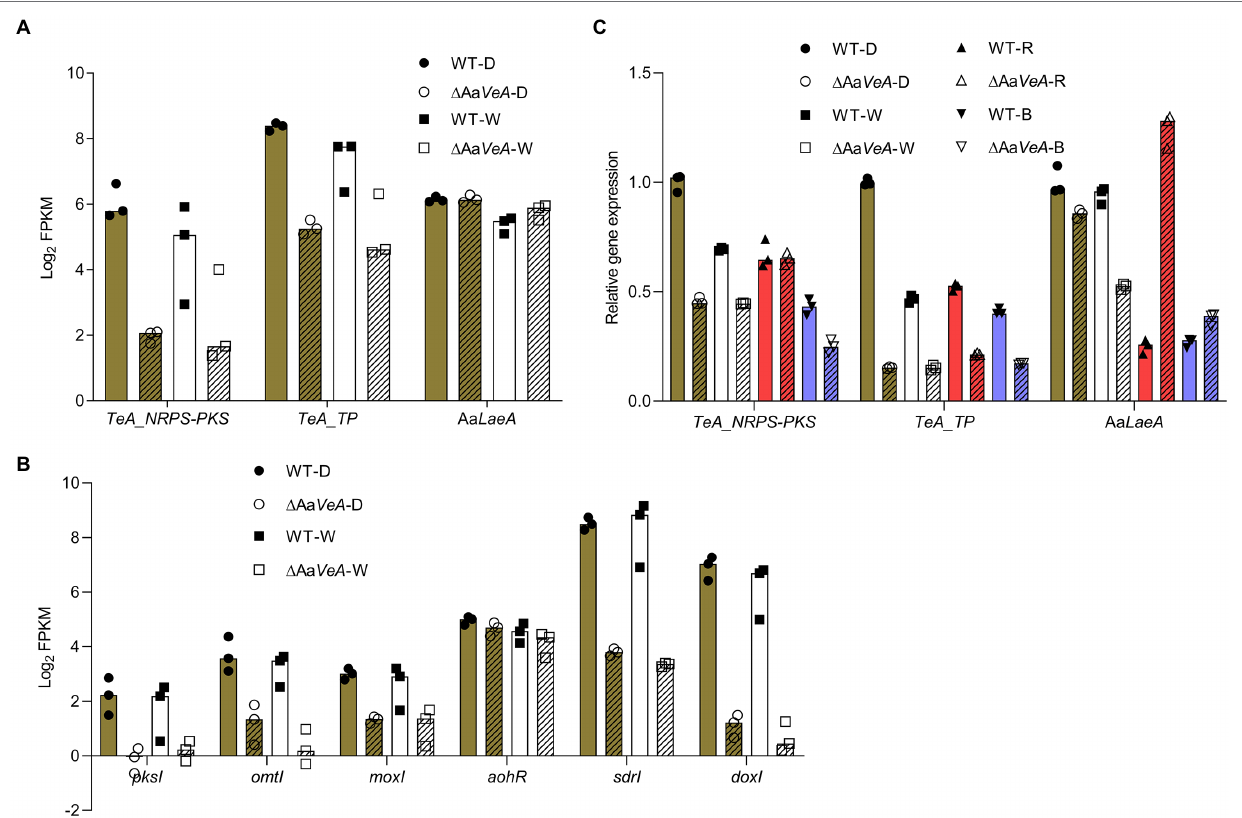
FIGURE 6 | The expression analyses of biosynthetic and regulatory genes involved in mycotoxin biosynthesis. The biosynthetic and regulatory genes contain the biosynthetic clustered genes of TeA and AOH/AME, and the master regulator gene of secondary metabolites Aa LaeA in Alternaria alternata . The results of the gene expression analyses were plotted using the median with range and separately expressed as the scatter dots. (A) The expression level of TeA biosynthetic clustered genes and Aa LaeA was expressed as the value of log 2 FPKM from the transcriptomic analysis. (B) The expression level of biosynthetic clustered genes for AOH and AME biosynthesis was expressed as the value of log 2 FPKM from the transcriptomic analysis. (C) The relative gene expression was confirmed by reverse transcription quantitative real-time PCR (RT-qPCR) and calculated by the 2 - ΔΔ Ct